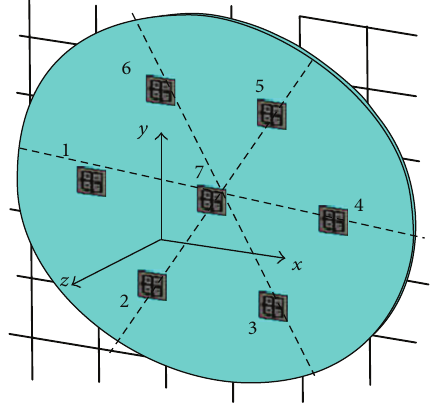
Figure 10: 7 elements array configuration—3D view.